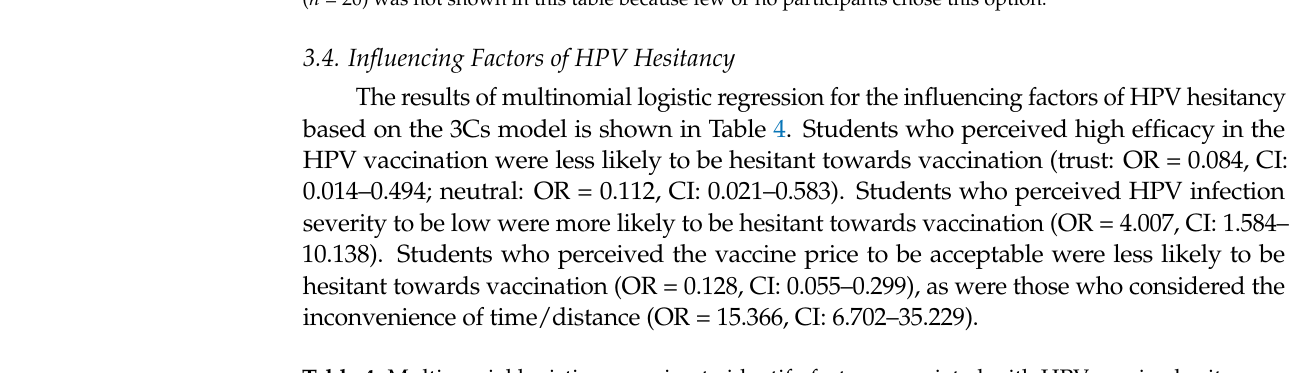
Table 4. Multinomial logistic regression to identify factors associated with HPV vaccine